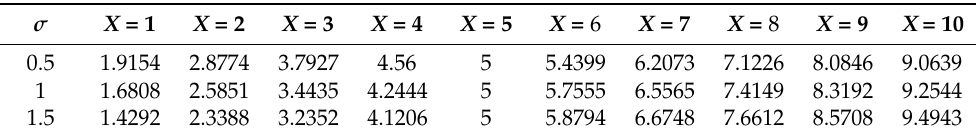
Table 9. Dependence of the value of the function f m ( X ) on the standard deviation parameter σ of the function f ( θ ) and the grade X in case 5, when µ = 5, k = 1.